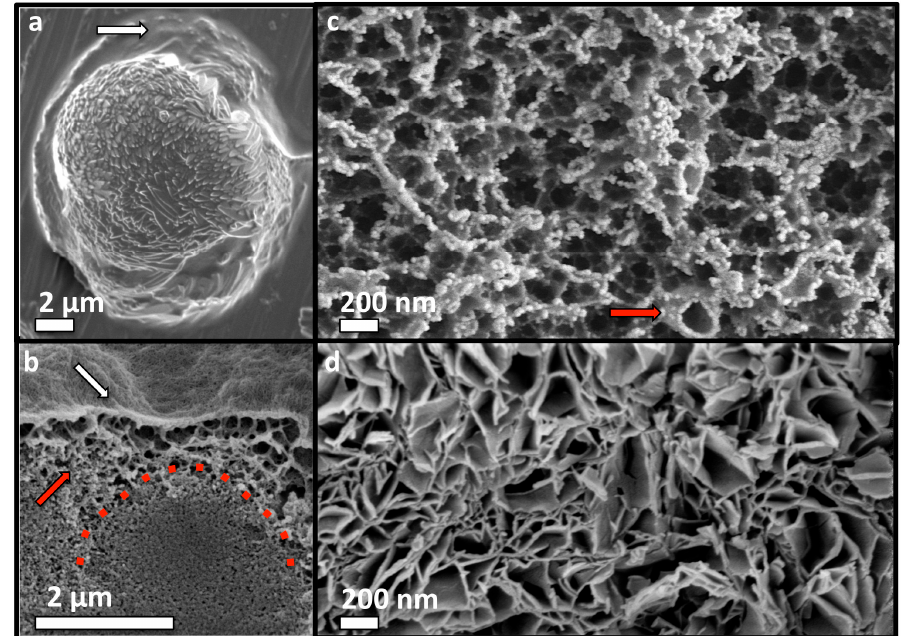
Figure 7. Adhesive mechanism and macrostructure of PM-CPC. ( a ) Adhesion and wetting of a substrate surface occurred via an organic phase that appeared on the surface of PM-CPC (white arrow, 72% PM-CPC, aluminum surface). ( b ) A cross-section of a PM-CPC disc confirmed that the surface appeared amorphous/organic (white arrow, 16% PM-CPC, 0.25 L/P), though closer inspection revealed that the organic phase was heavily mineralized with small, spherical clusters of calcium phosphate. The organic phase extended from the surface to the interior of PM-CPC, in the form of a porous, honeycomb like network (( b ), red arrow). Unreacted α TCP particles appear in the interior of PM-CPC (red dotted line). ( c ) A cross-section of the adhesive interface (53% PM-CPC, 0.25 /LP), taken at the fracture interface of thin layer PM-CPC, after shear testing, revealed the organic network seen in ( b ), is comprised of organic (phosphoserine) meso-scale particles, which form an interconnected fibrillar, polymer like network. Individual meso-scale organic particles that comprise the network can be distinguished (( c ) red arrow). ( d ) In comparison, α TCP cement without phosphoserine (0% PM-CPC, 0.25 /LP) contains irregular porosity arising from the random aggregation of plate-like hydroxyapatite crystals. Scale bar dimensions are 2 µm in ( a ), ( b ); and 200 nm in ( c ), ( d ).